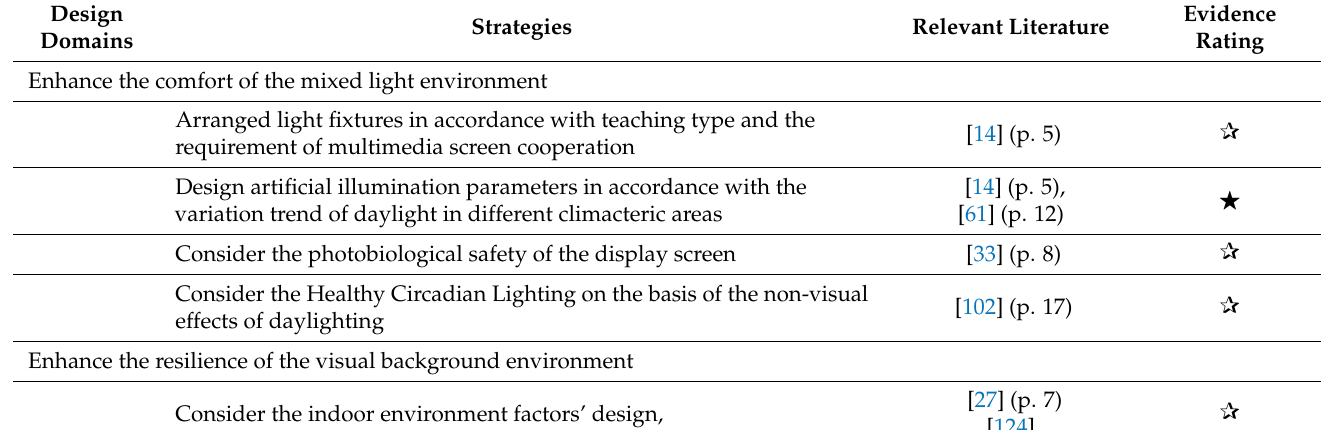
Table 3. Visual health design guidelines for school architecture.